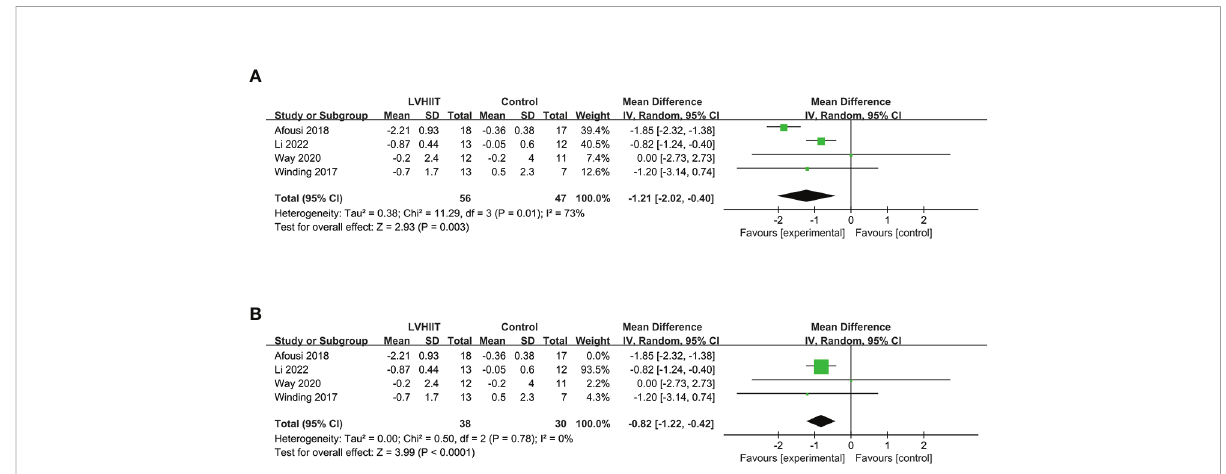
FIGURE 2 (A) Forest plot for the meta-analysis of (A) fasting blood glucose and (B) after sensitivity